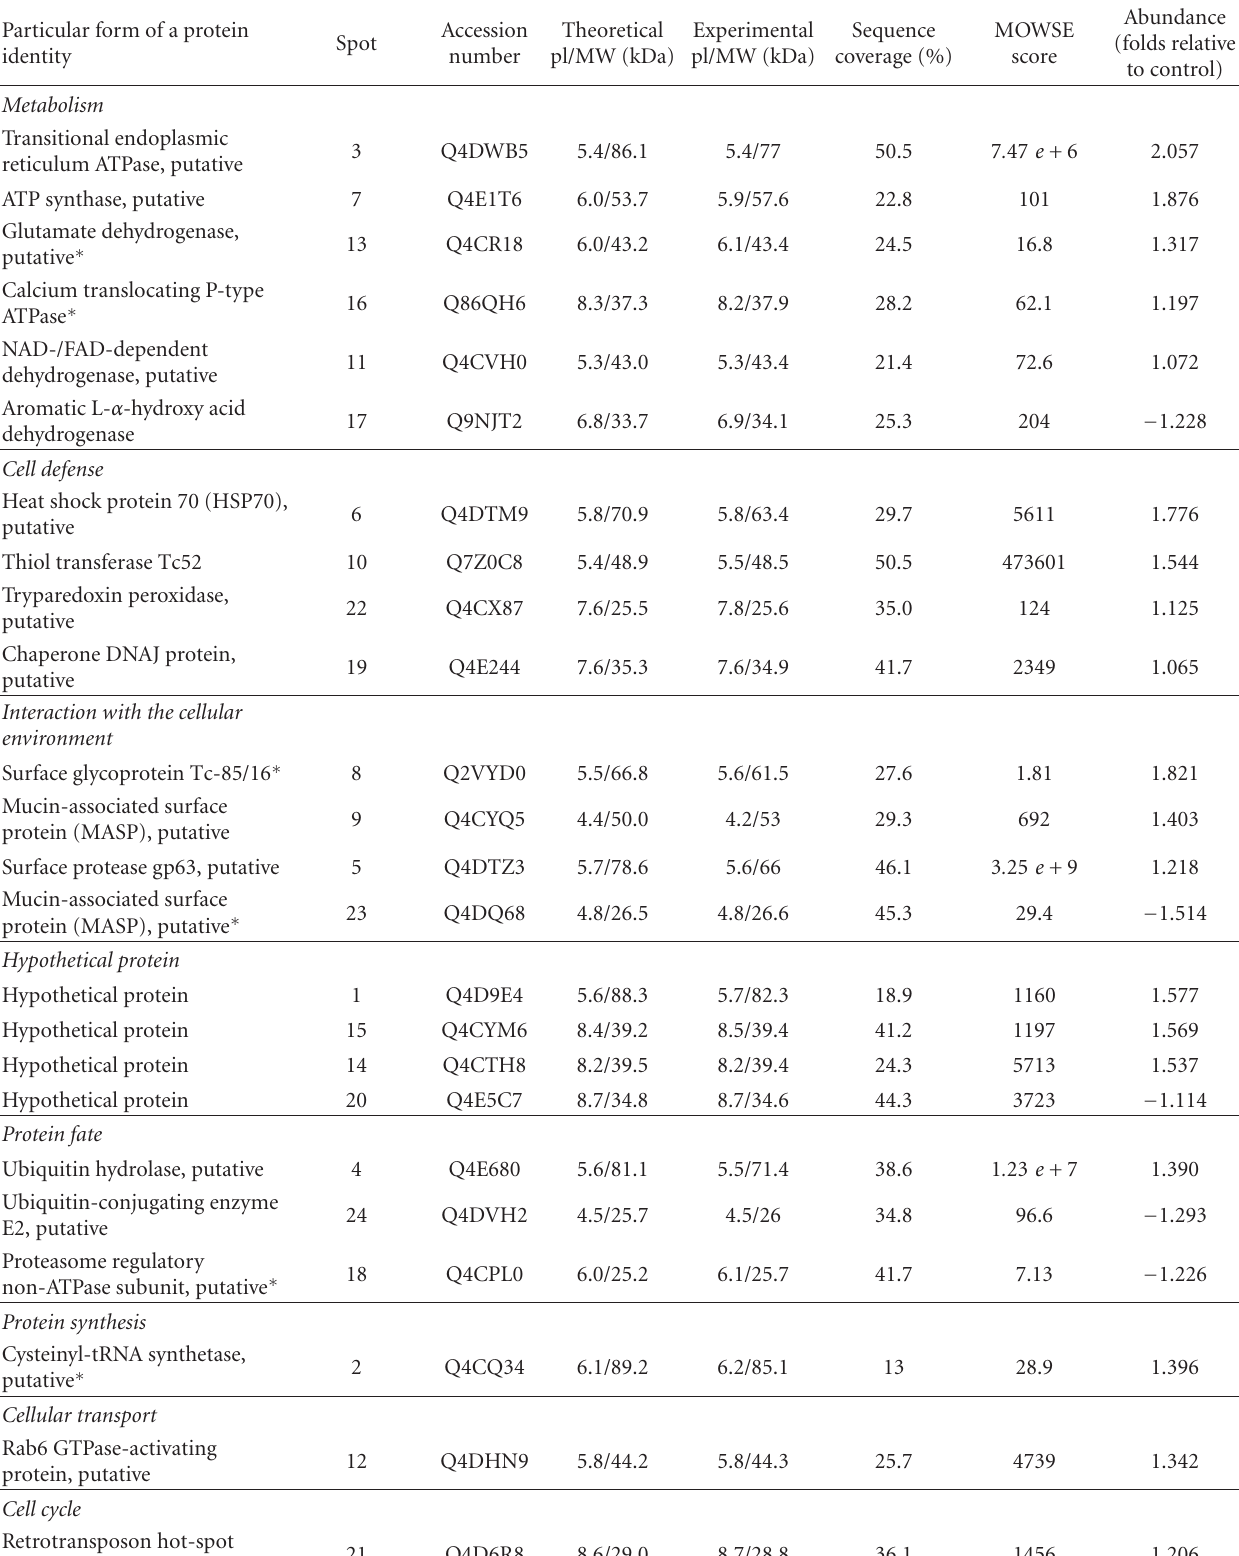
Table 1: Particular form of proteins with a di ff erent abundance from T. cruzi epimastigotes subjected to heat shock identified by MALDI-